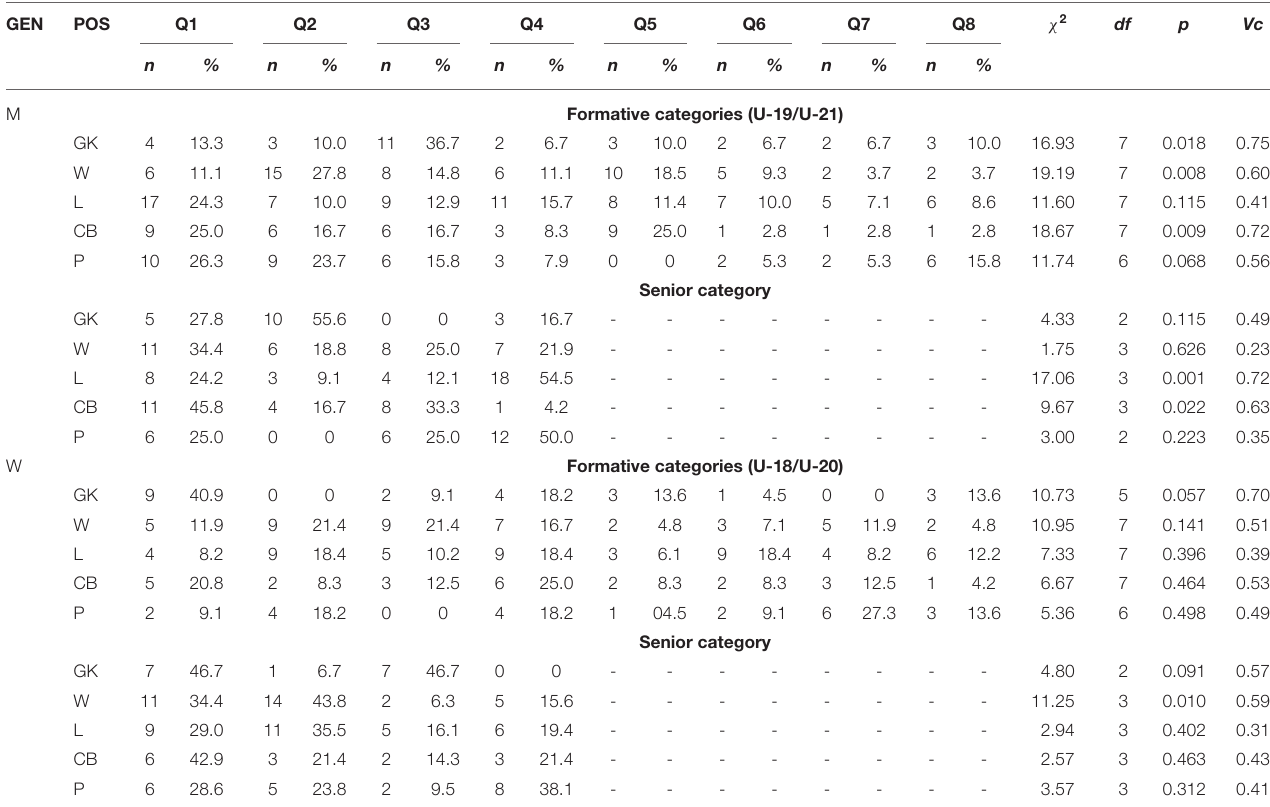
TABLE 2 | Quarterly distribution ( n and % ) for playing position by gender and competitive level.